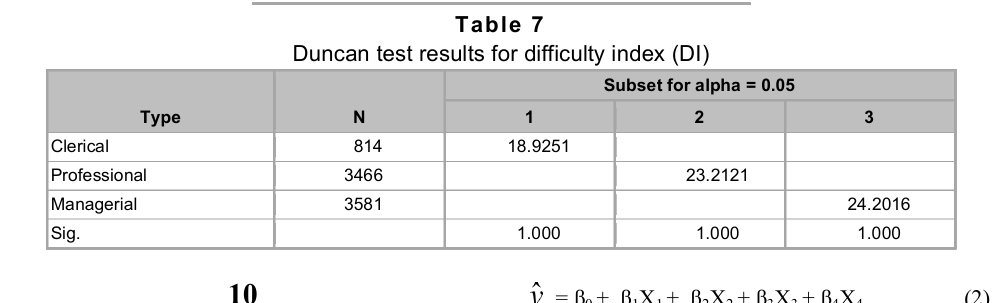
Subset for alpha = 0.05